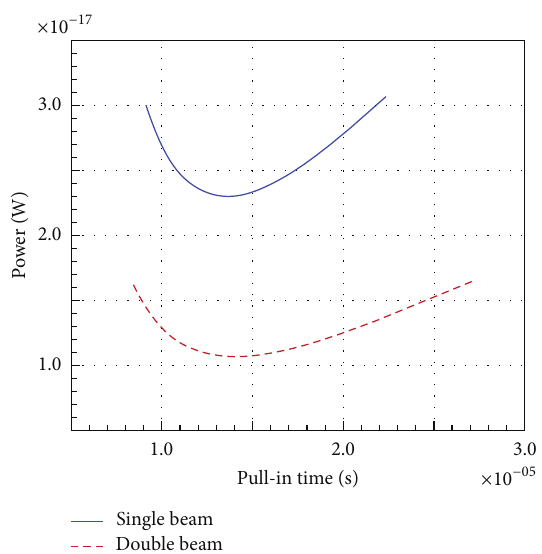
Figure 7: Variation of the electrostatic energy versus the pull- in time by varying the DC voltage for simple and double beam microswitch designs.